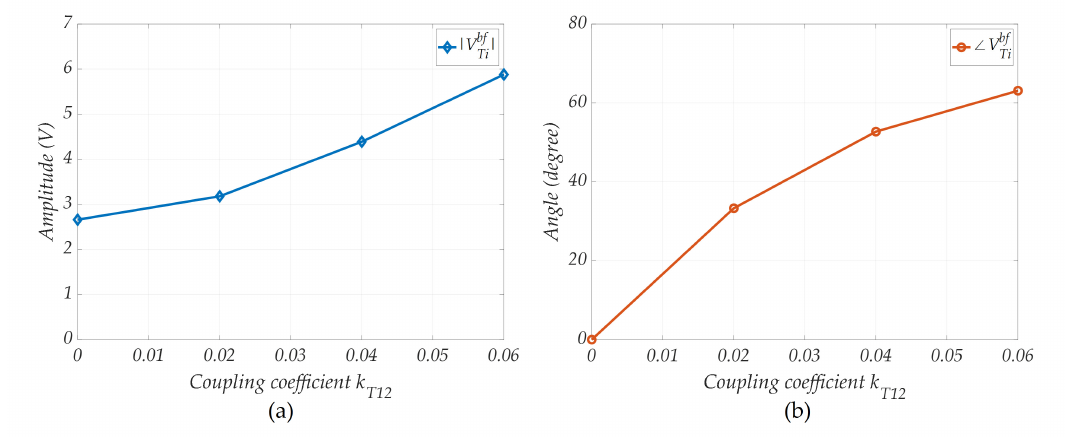
# » Figure 10. V bf when P in is fixed at 5 W: ( a ) | V bf T Figure 11